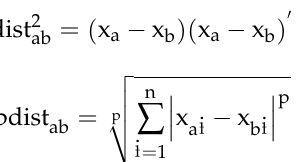
Figure 2. ( a ) Schematic illustration of Arduino sensor modules (ASM) monitoring installation setup; ( b ) top view of the stainless steel strainer casing for the ASM; and ( c ) side view of ASM strainer horizontally flanged on the pile cap anchored on the concrete girder for instrument safety from external impacts.